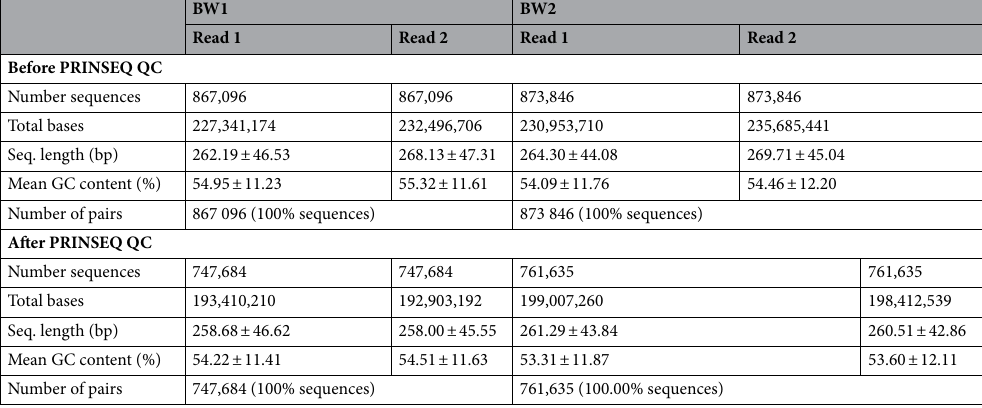
Table 1. Characteristics of the paired-end raw sequences obtained after Illumina MiSeq sequencing of As Burgas water before and after quality control (QC) with PRINSEQ. Read 1 and Read 2 correspond to the paired